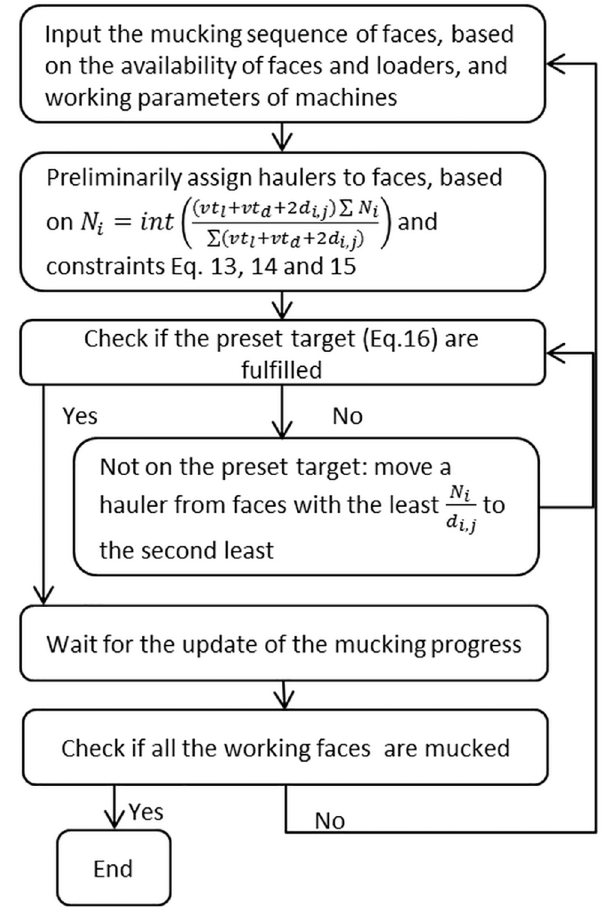
Fig 7. Flow chart of the mucking